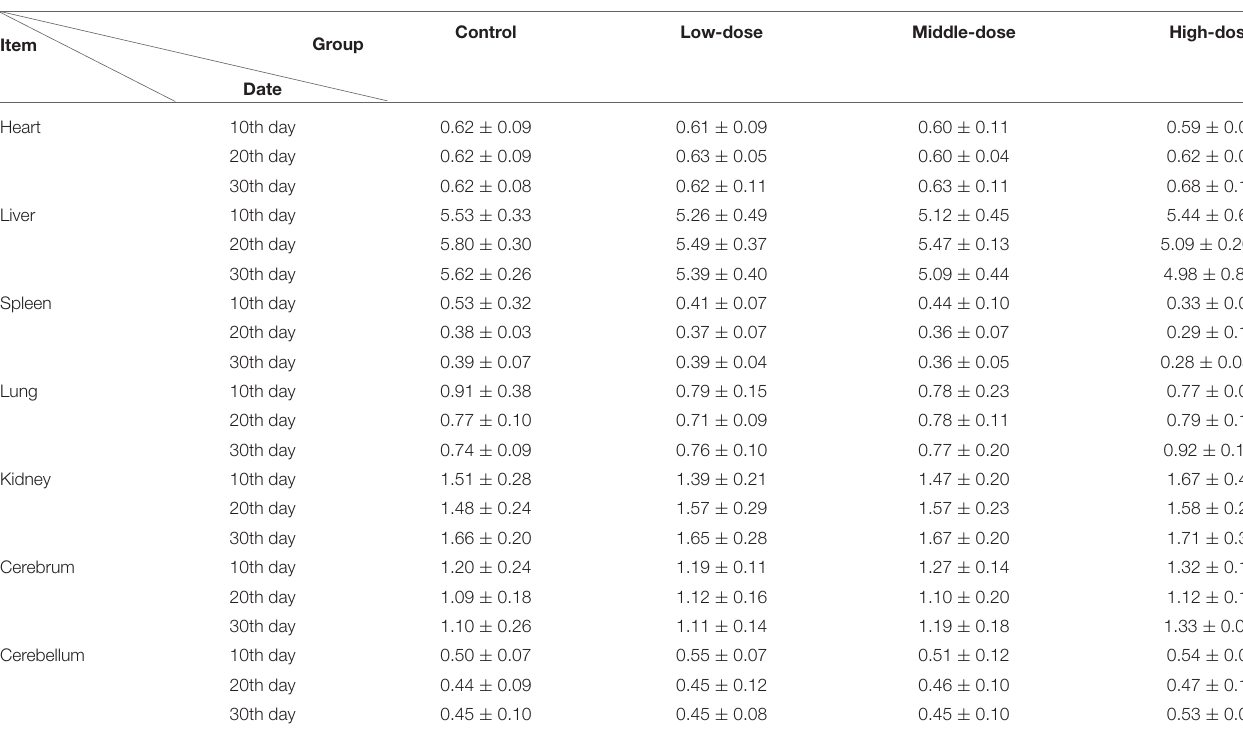
n = 10, the data in table are M ± SD, means with no mark in the same row differ insignificantly (p > 0.05); while with “ * ” differ significantly (p < 0.05) with “ ** ” differ extremely significant.